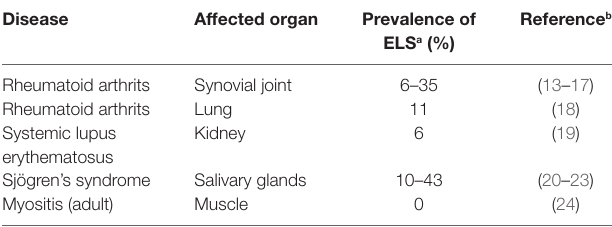
TaBLe 1 | Prevalence of fully developed ectopic lymphoid structures (ELS) in human autoimmune